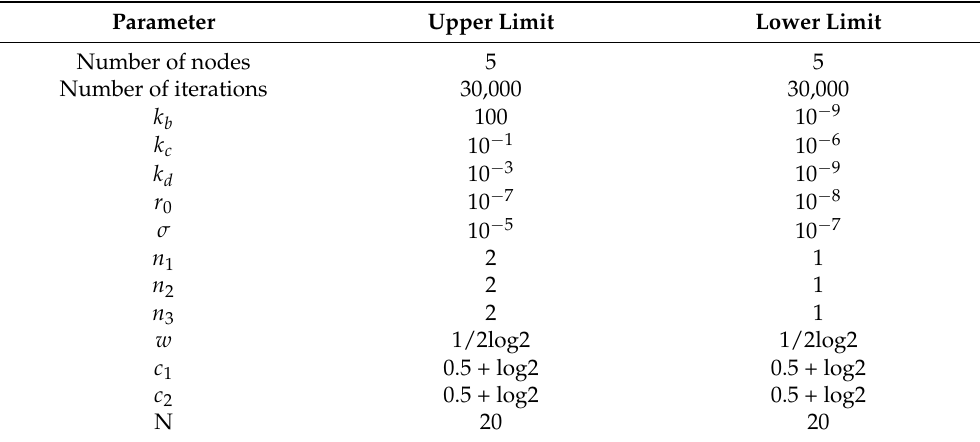
Table 1. The upper and lower limits for each of the input parameters of AKPE. Parameter